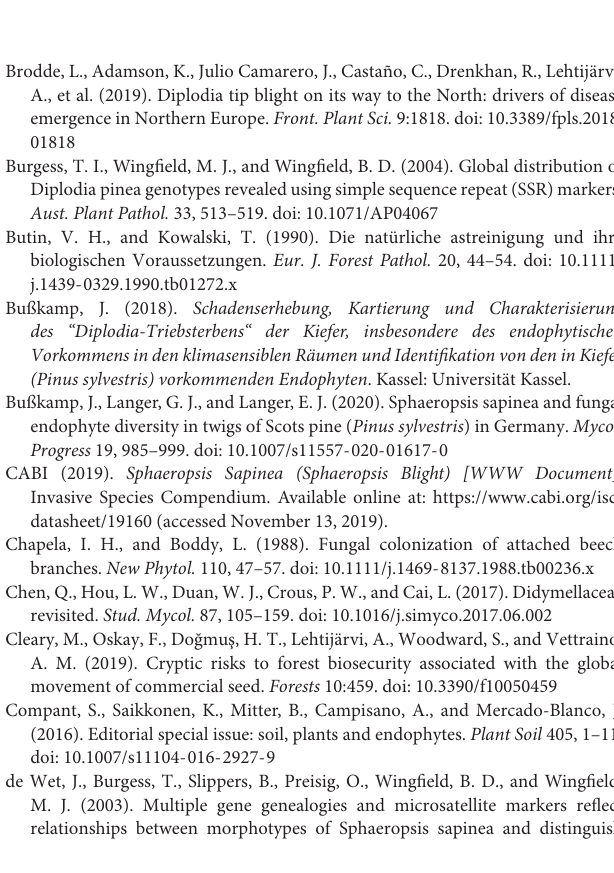
Supplementary Figure 1 | Boxplot representing the mortality of the twigs due to fungal (A) and water (B) treatment. Supplementary Figure 2 | Boxplot presenting number of dead twigs after Sphaeropsis sapinea treatment in different water treatments. Supplementary Table 1 | Number of dead twigs in the end of the